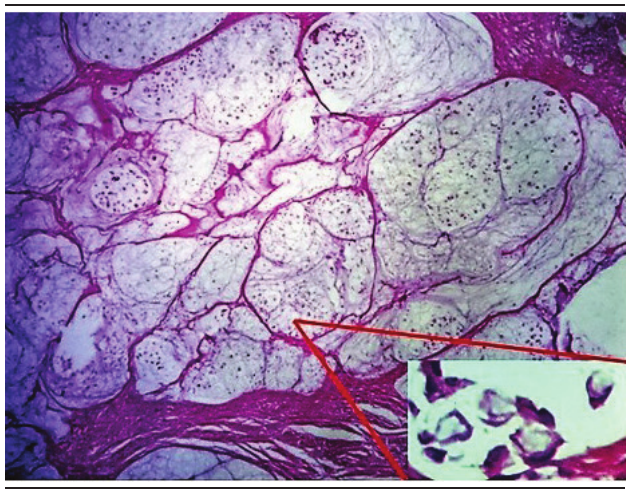
FigurE 1 − Photomicrograph showing areas with mucinous differentiation in urethral adenocarcinoma (100×). In detail (right and below), neoplastic cells with signet-ring appearance (400×)